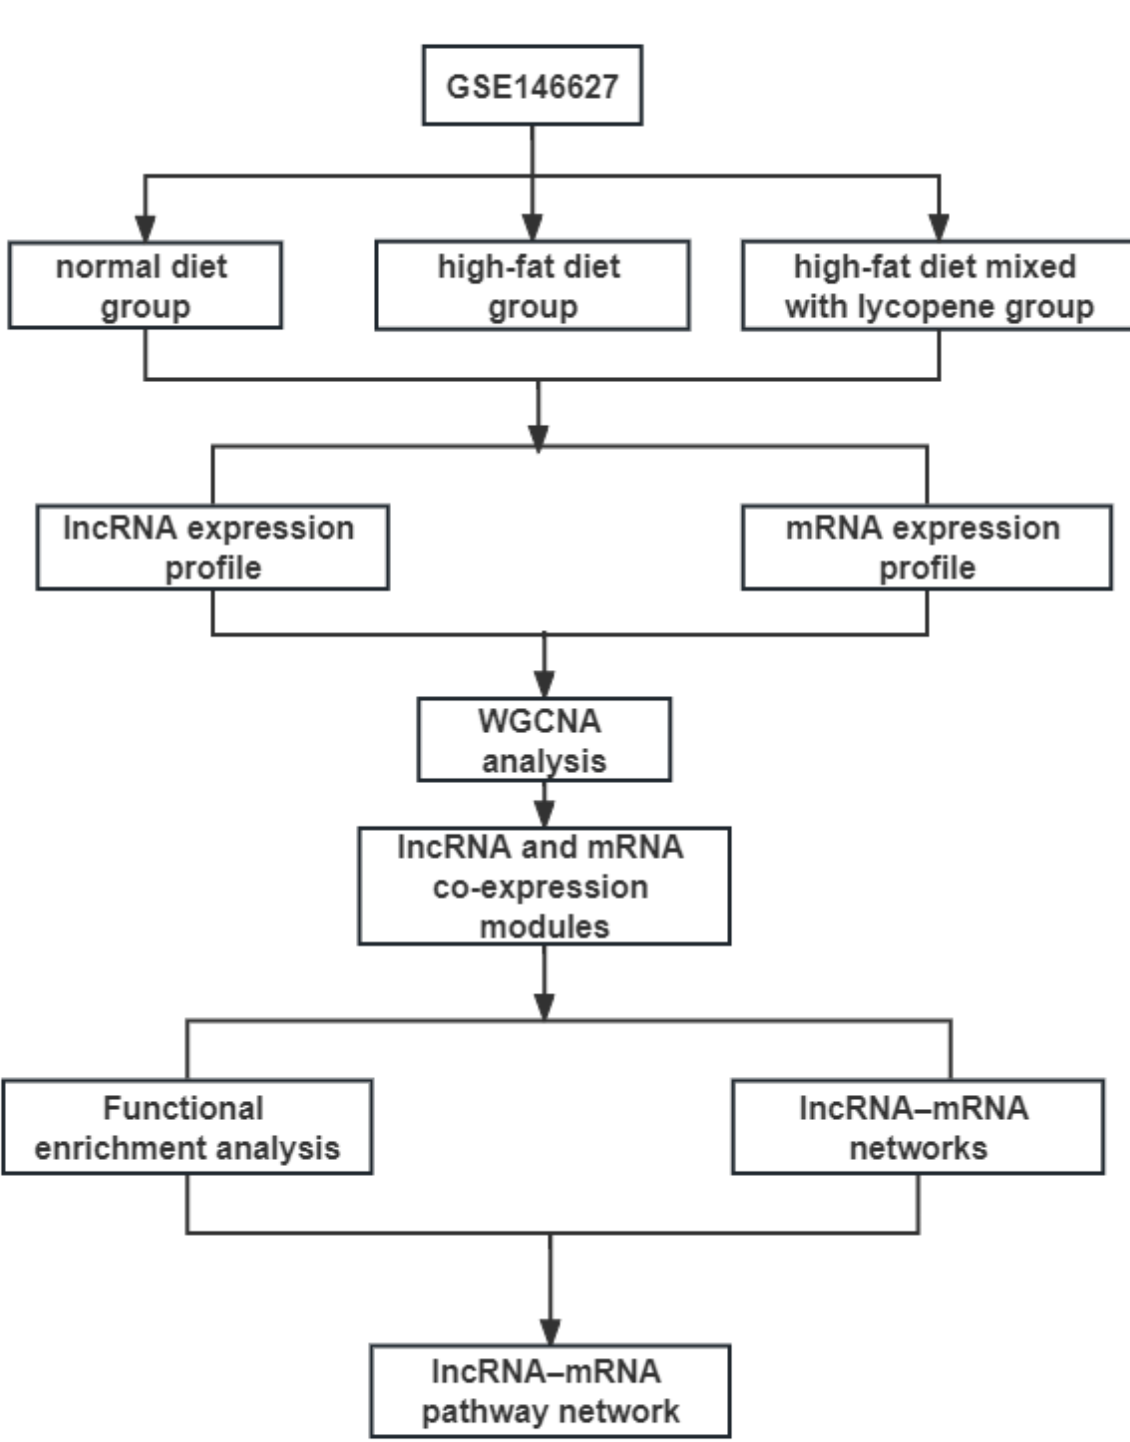
Figure 1. The main workflow of the study. WGCNA, weighted correlation network analysis.